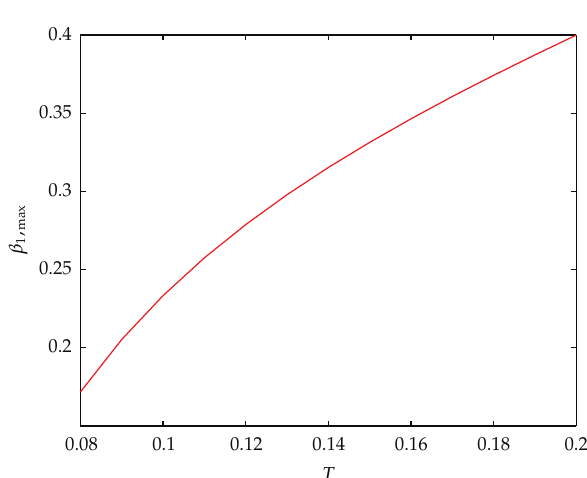
Figure 6: β 1 , max versus T for the class of systems given in Example 4.5.